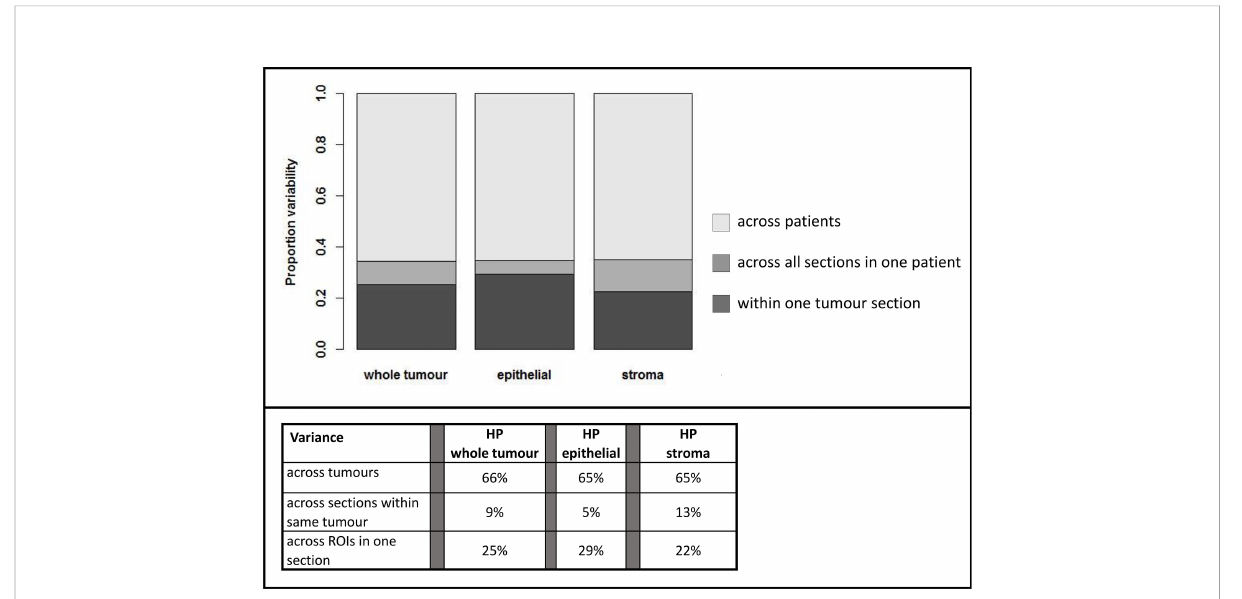
FIGURE 5 Estimation of variability of hypoxia estimated by De fi niens Developer analysis within given patients and across patients. HP; hypoxic